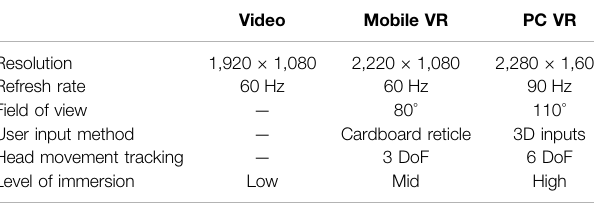
TABLE 1 | The experimental conditions of low, middle and high immersion.